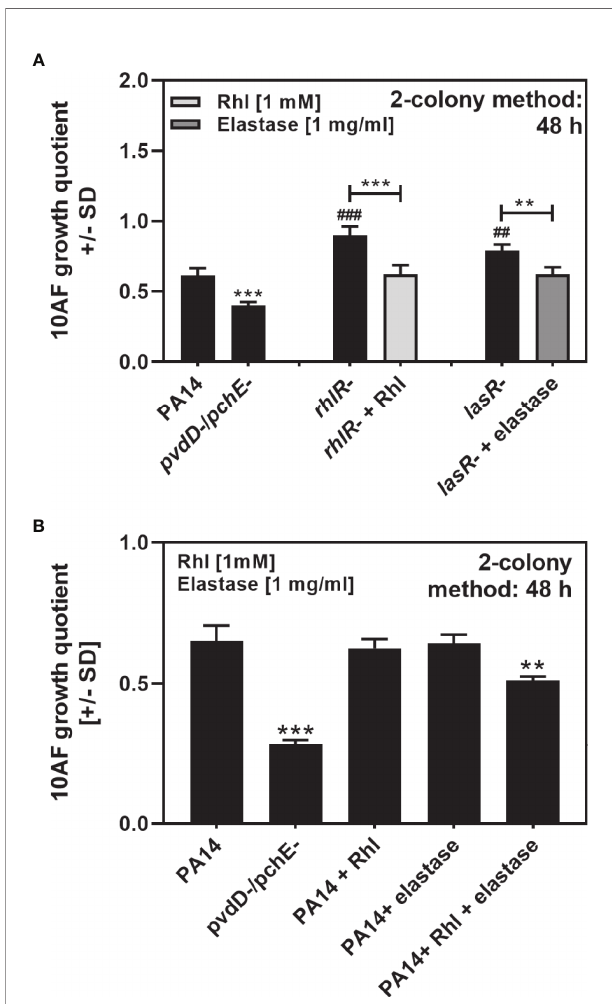
FIGURE 8 | Rhamnolipids and elastase complement the loss of antifungal activity by their respective mutants, and in combination increase antifungal activity of PA14 wild type. (A, B) Six-millimeter paper disks were placed on RPMI agar. Ten microliters of A. fumigatus 10AF conidia (10 7 /ml, prepared in RPMI) was added to these paper disks. (A) Ten microliters of PA14, PA14 pvdD-/pchE- , PA14 lasR- , or PA14 rhlR- bacteria (10 9 /ml, prepared in RPMI) was placed on paper disks 15 mm distant from the disks carrying 10AF. Bacterial suspensions were supplemented with 10 µl RPMI (for PA14 or PA14 pvdD-/pchE- ), 10 µl elastase (of 1 mg/ml for PA14 lasR- ), or 10 µl rhamnolipids (of 1 mM, for PA14 rhlR- ). (B) Ten microliters of PA14 or PA14 pvdD-/pchE- bacteria (10 9 /ml, prepared in RPMI) was placed on paper disks 15 mm distant from the disks carrying 10AF. Bacterial suspensions were supplemented with 10 µl RPMI (for PA14 or PA14 pvdD-/pchE- ), 5 µl RPMI plus 5 m l elastase (of 2 mg/ml), 5 µl RPMI plus 5 µl rhamnnolipids (of 2 mM), or 5 ul elastase plus 5 µl rhamnolipids, keeping the amounts of elastase and rhamnolipids identical to (A) Plates were incubated at 37°C for 48 h, and growth quotients were determined by the two-colony method. Comparison: RPMI controls vs . all other bars, or as indicated by the ends of the brackets. Statistical analysis, t-test: two, or three asterisks or pound signs = p ≤ 0.01 and p ≤ 0.001, respectively. Asterisks represent signi fi cant increases; pound signs represent signi fi cant decreases in antifungal